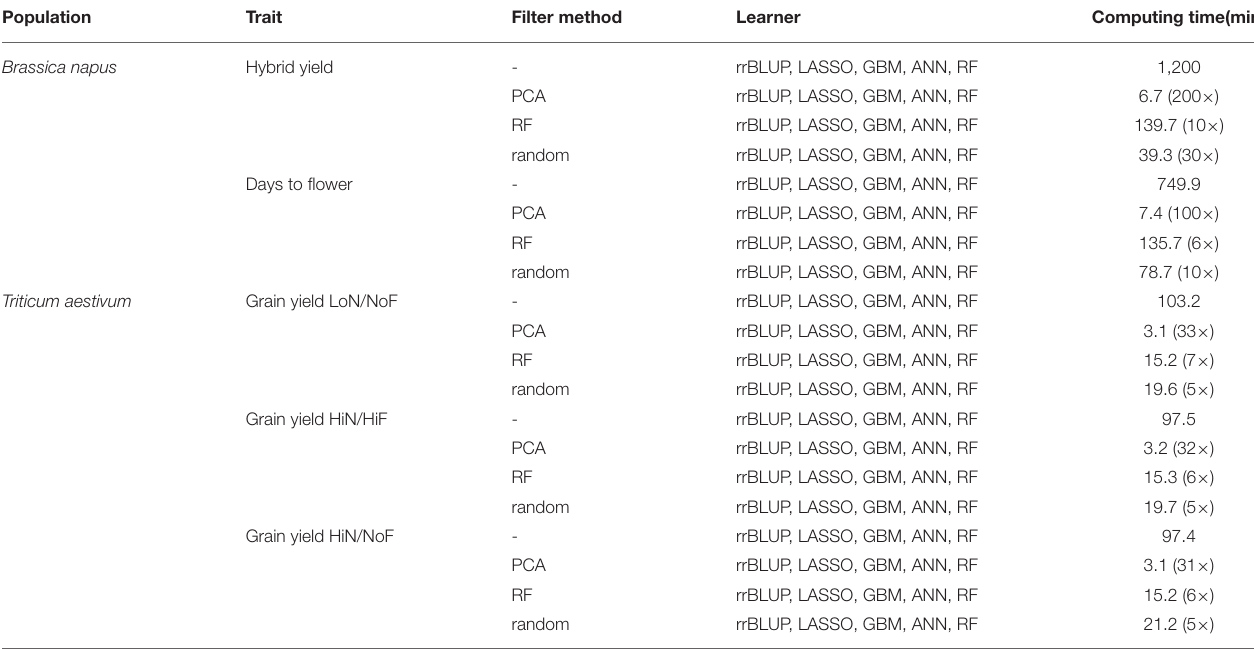
TABLE 2 | Processing time for filter methods, principal component analysis-(PCA-) based data reduction and random forest-(RF-) based FS, combined with linear and nonlinear learners, ridge regression best linear unbiased prediction (rrBLUP), least absolute shrinkage and selection operator (LASSO), gradient boosting machines (GBM), artificial neural networks (ANN), and